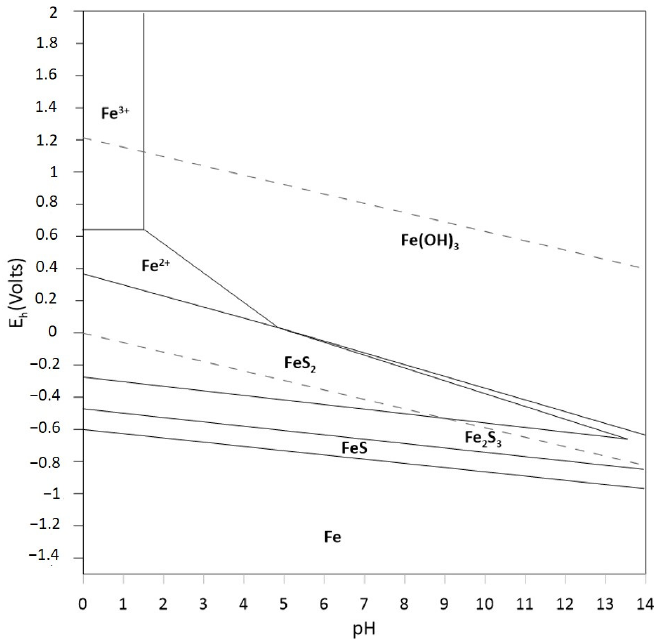
Figure 2. Pourbaix diagram, system Fe-S-H 2 O at 25 °C, 1 mol L − 1 Cu 2+ , Fe and S (HSC Chemistry 9.0, Metso Outotec, Helsinki, Finland).